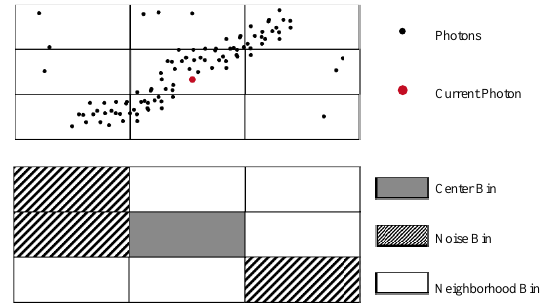
Figure 5 . The strategy used by the algorithm for selecting noise areas. The top figure shows the photon distribution, and the bottom picture shows the grid division. According to the number of photons in each bin, the shadow bins are selected as the noise